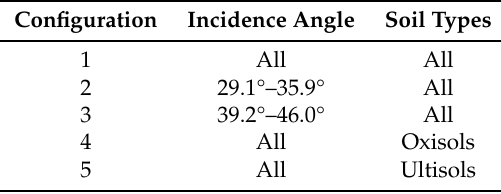
Table 4. Configurations with varying incidence angle and soil type used for performance comparisons.